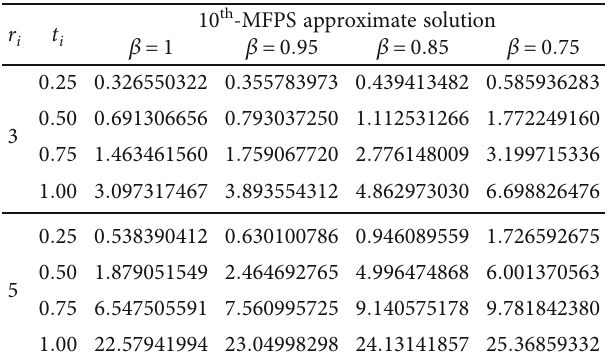
Table 3: Numerical results of the approximate solution at n = 10 for di ff erent values of β and parameter r for Example 2.